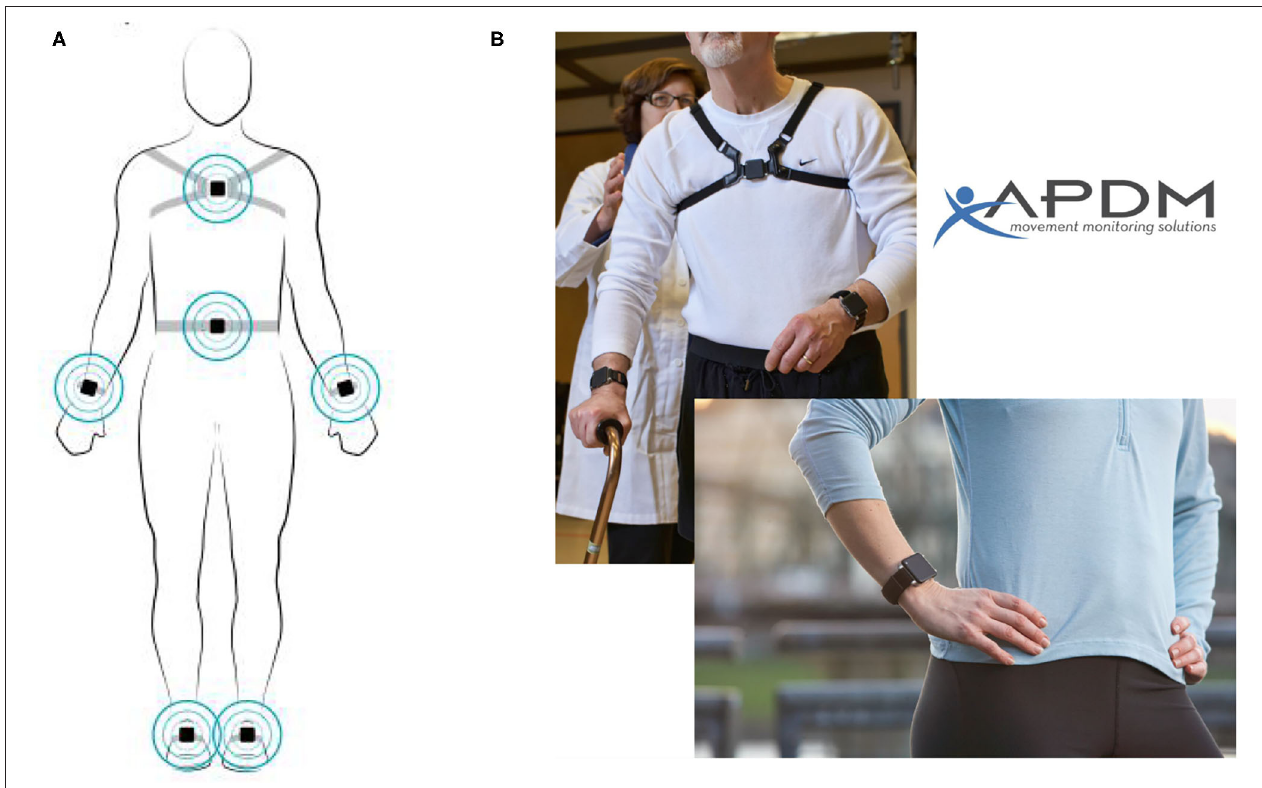
FIGURE 1 | Sensors on the body. Reproduced with permission from APDM Inc. (A) Location of Opal sensors. (B) Example of sensors attached to the sternum and bilateral wrists.